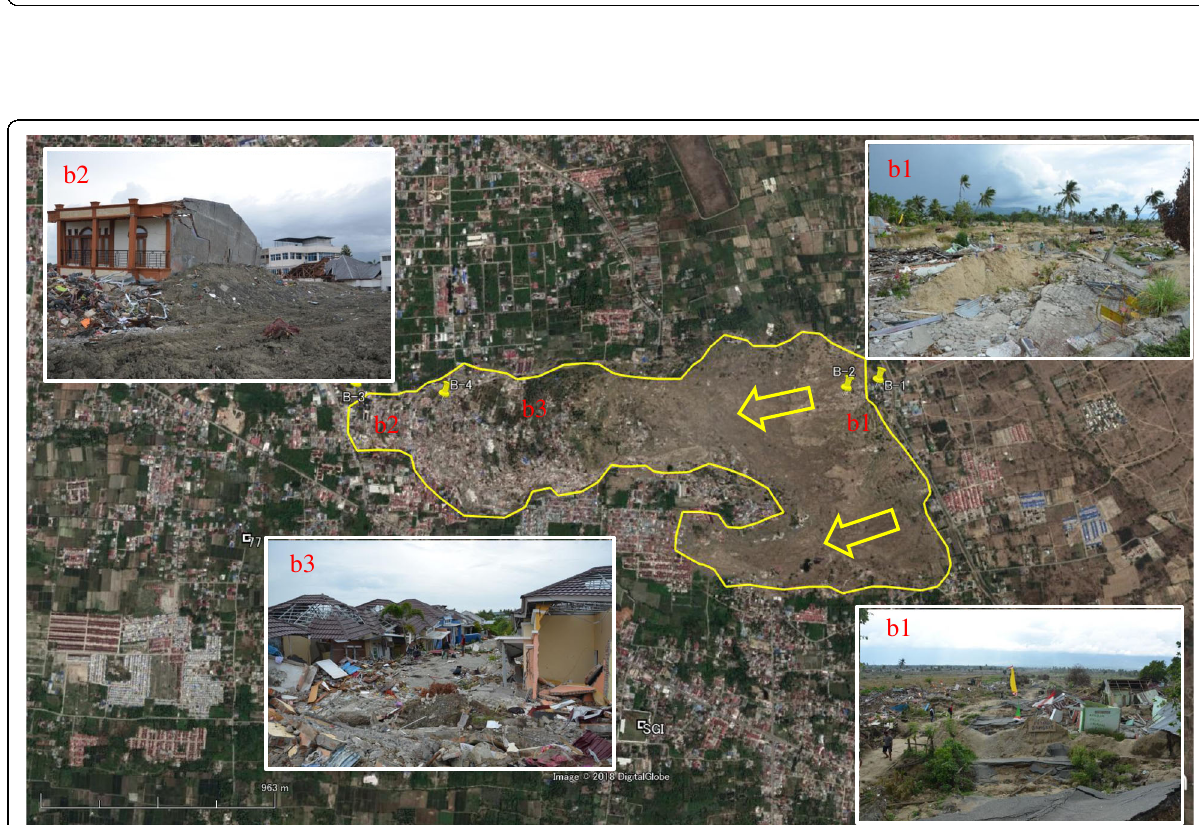
Fig. 9 Satellite photo by Google Earth and some photos of damage in Balaroa district in Palu